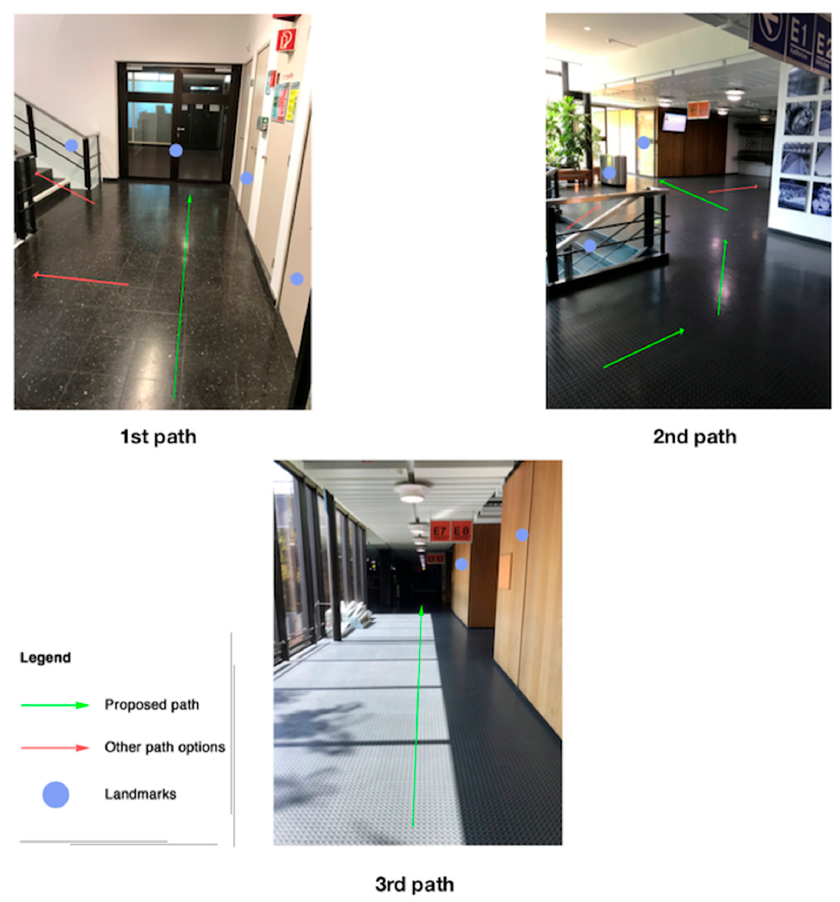
Figure 4. Three different sub-paths of the wayfinding’s routing path.